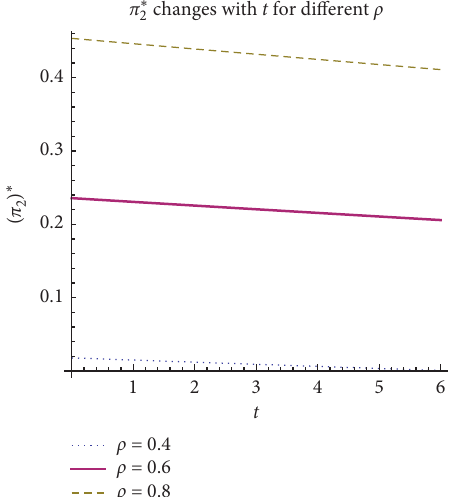
Figure 8: Values of π ∗